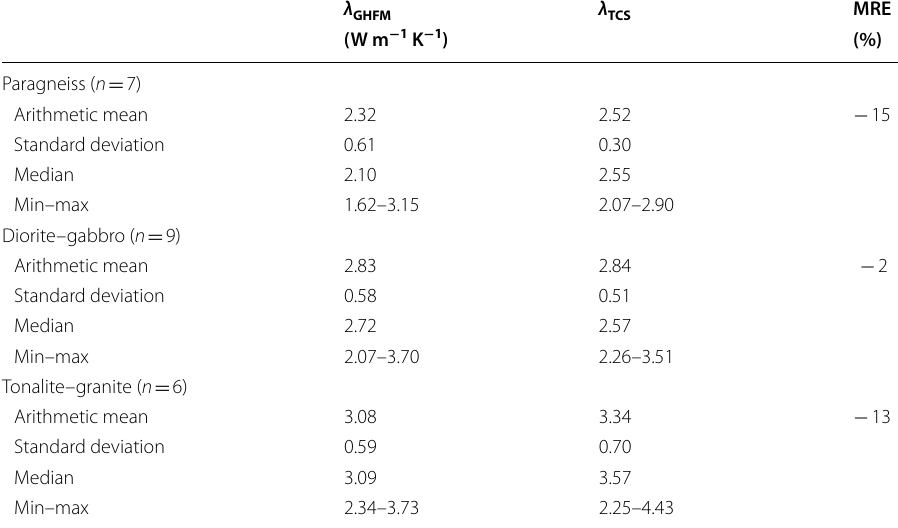
Table 2 Thermal conductivity statistics of the main lithologies in Kuujjuaq